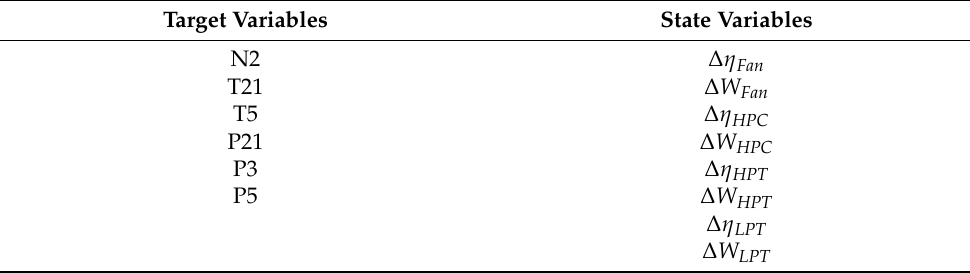
Table A4. Underdetermined solver, limited sensor